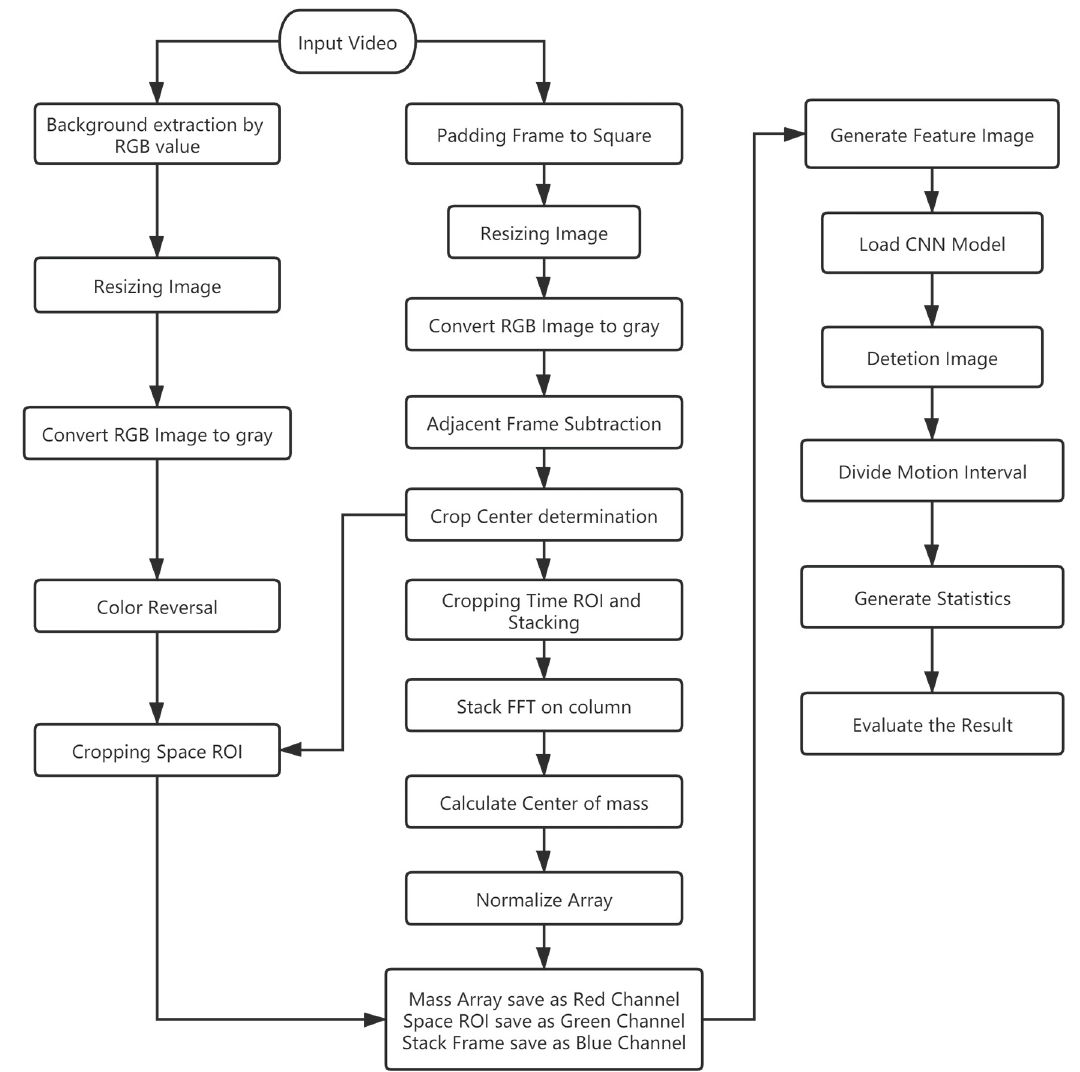
Figure 1. Software flowchart of the overall methodology.